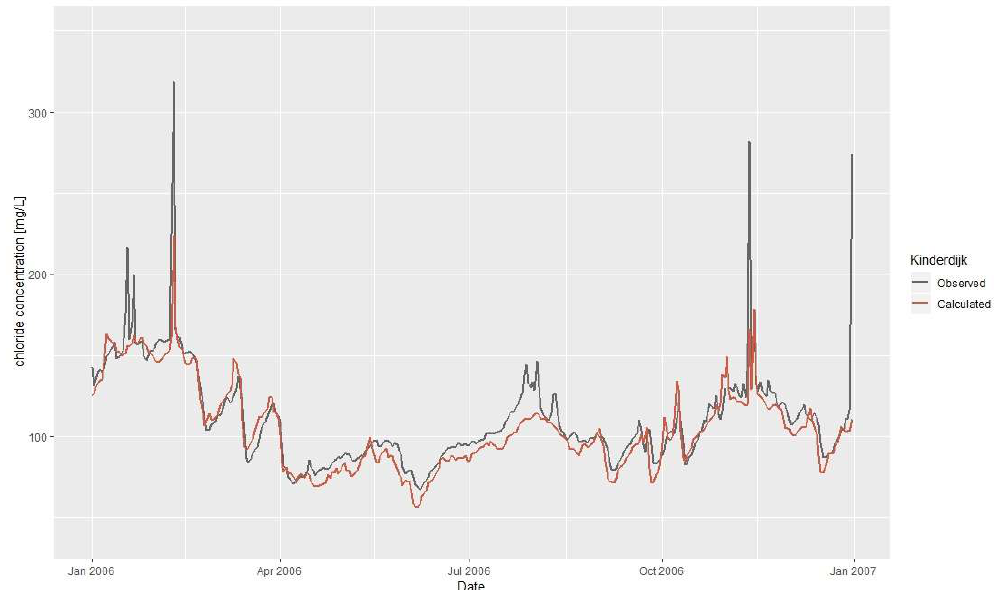
Figure 5. Observed and calculated chloride concentrations at Kinderdijk for the year 2006. Both observations and calculations are daily averaged based on 10 min data. Please note that for the validation runs, measured river chloride concentrations are used, while for the scenario runs (current and future climate), a discharge–salinity relation is